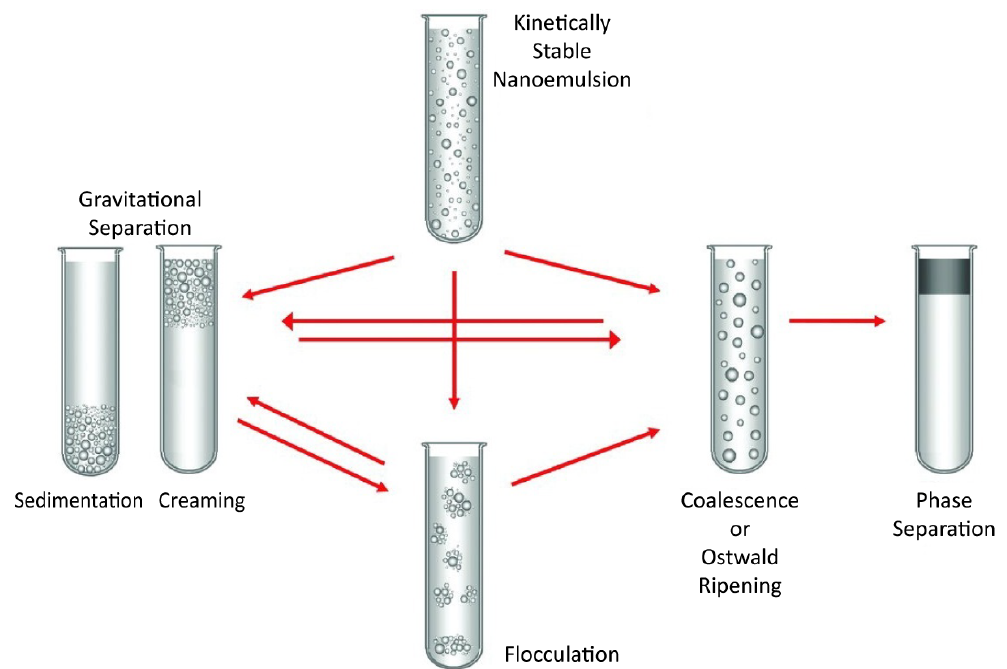
Figure 26. Schematic diagram showing the most common instability mechanisms that take place in emulsions. Figure reproduced from Ref.